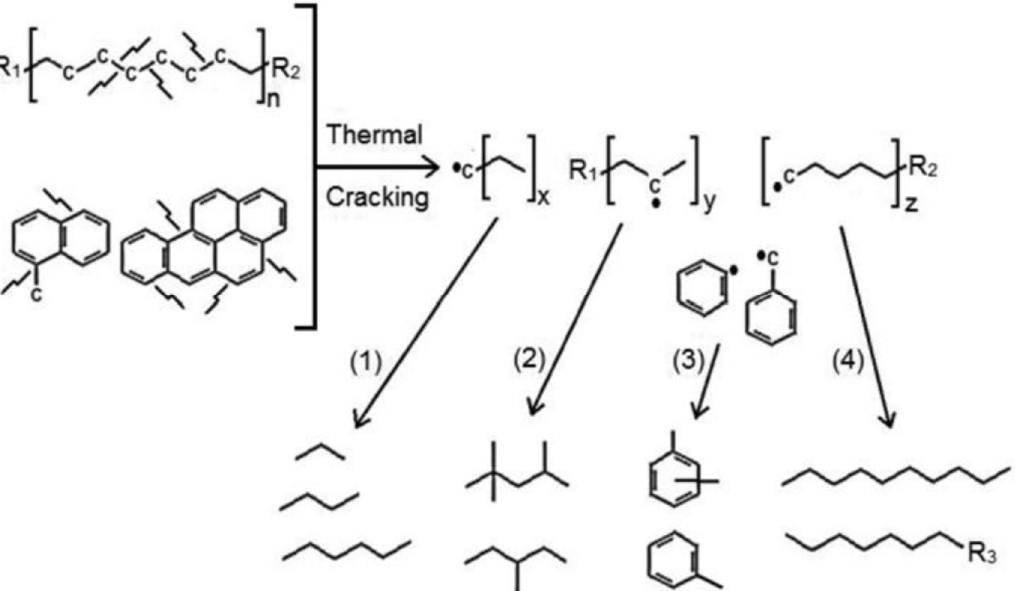
Figure 7. Proposed steps for thermal and catalytic distillation for the atmospheric residue of petroleum, where the steps are represented by (1) catalytic cracking, (2) isomerization, (3) alkylation, and (4) recombination.